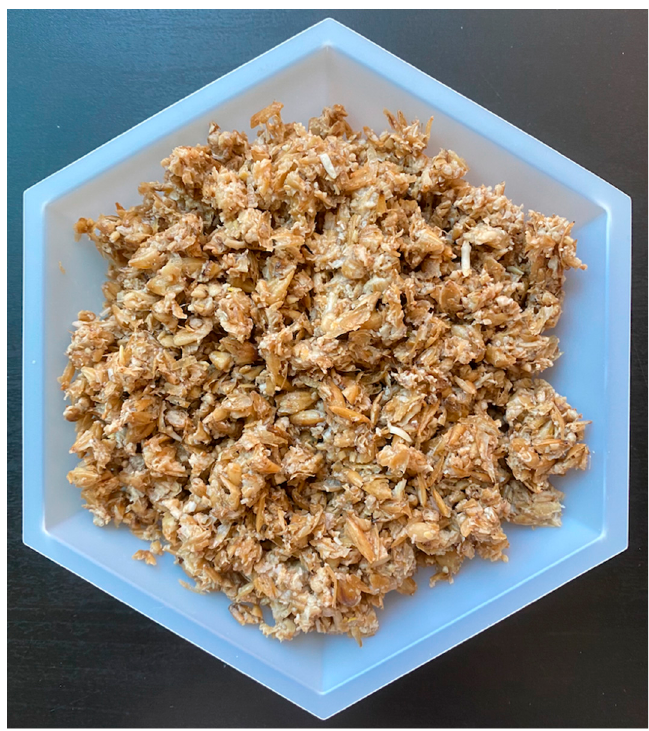
Figure 1. Brewer’s spent grain (BSG) consisting of barley malt removed from the lauter tun at the UC Davis Pilot Brewery. Photo courtesy of Emily Newman. Written permission was granted to the authors.